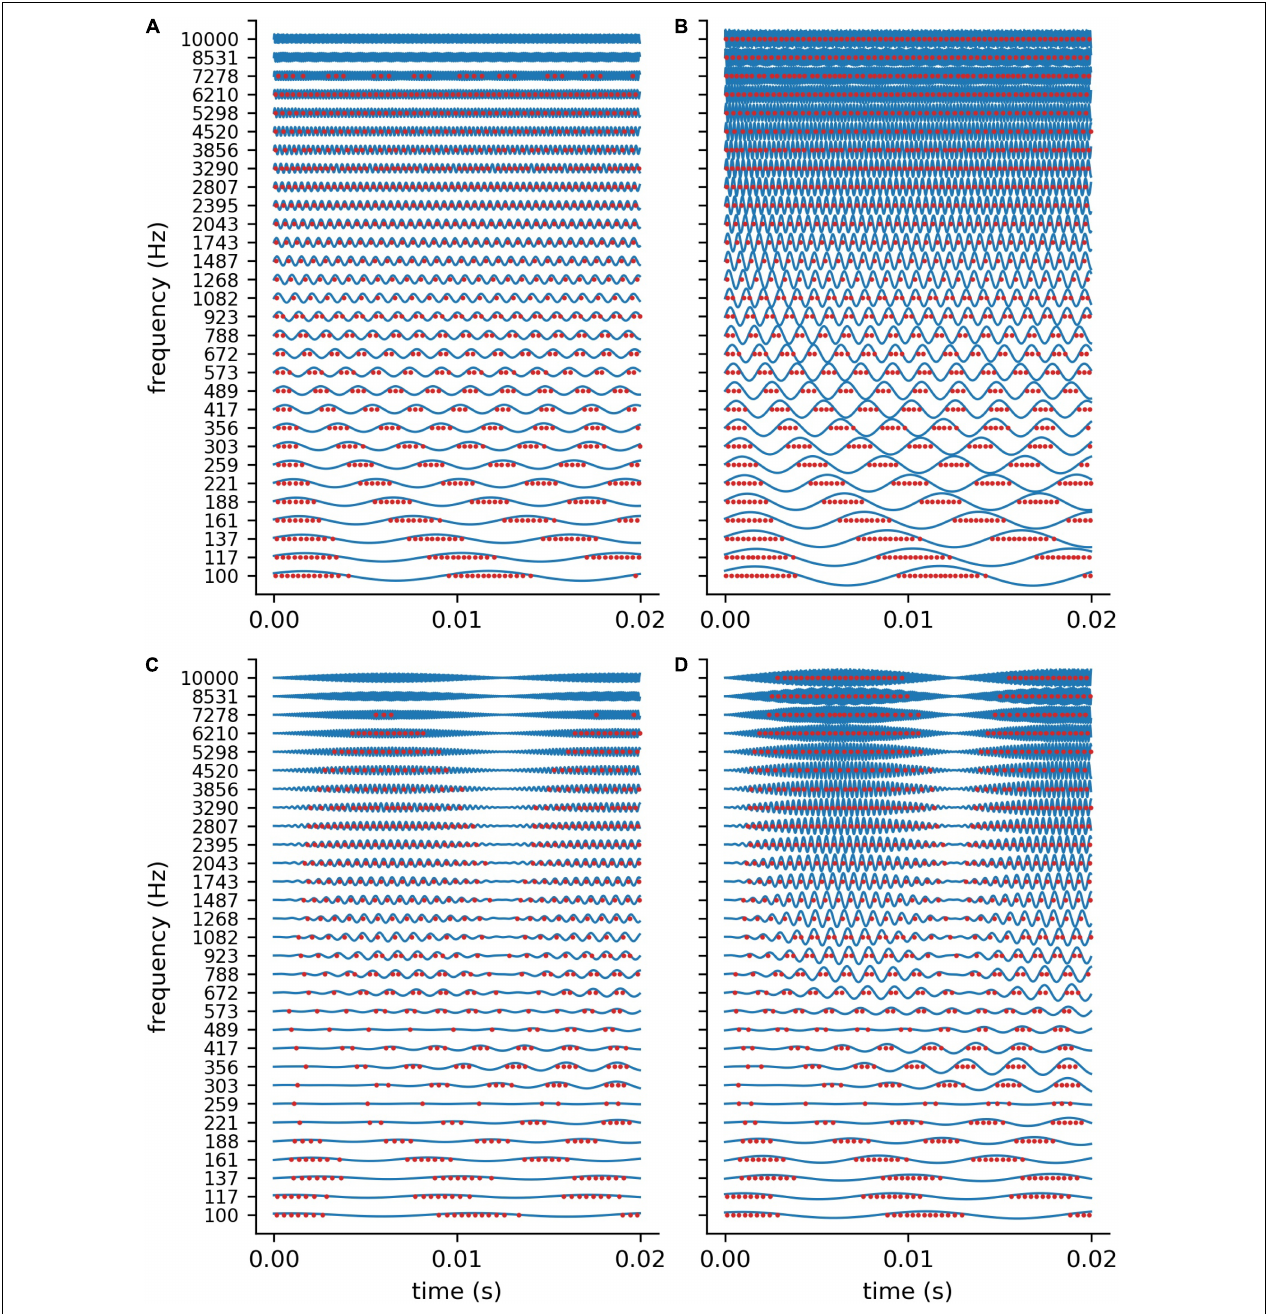
FIGURE 3 | DCN model response to sine waves. Shown are the spiking outputs of the LIF neurons for sine input with two different constant amplitudes ( A : 0.001, B : 0.002), and two different amplitude modulations (C,D) . For lower amplitudes (A) and higher frequencies the LIF neurons do not spike at all, whereas for higher amplitudes a rate code can be observed as the neurons’ maximum spiking rate is limited due to the refractory period. The parameters of the LIF neurons are chosen so that there is phase coupling in the frequency range which is relevant for speech